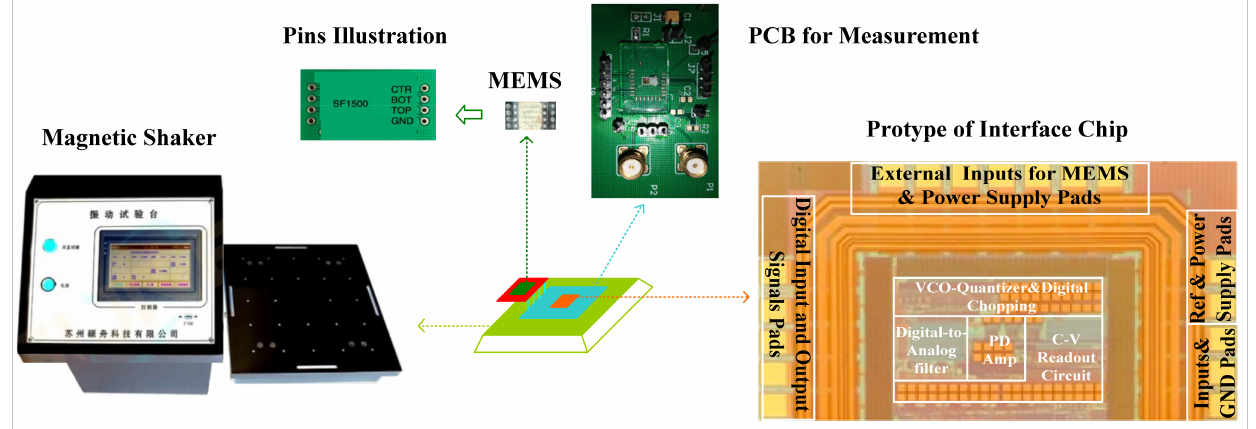
Figure 14. Interface chip protype and the interface measurement set